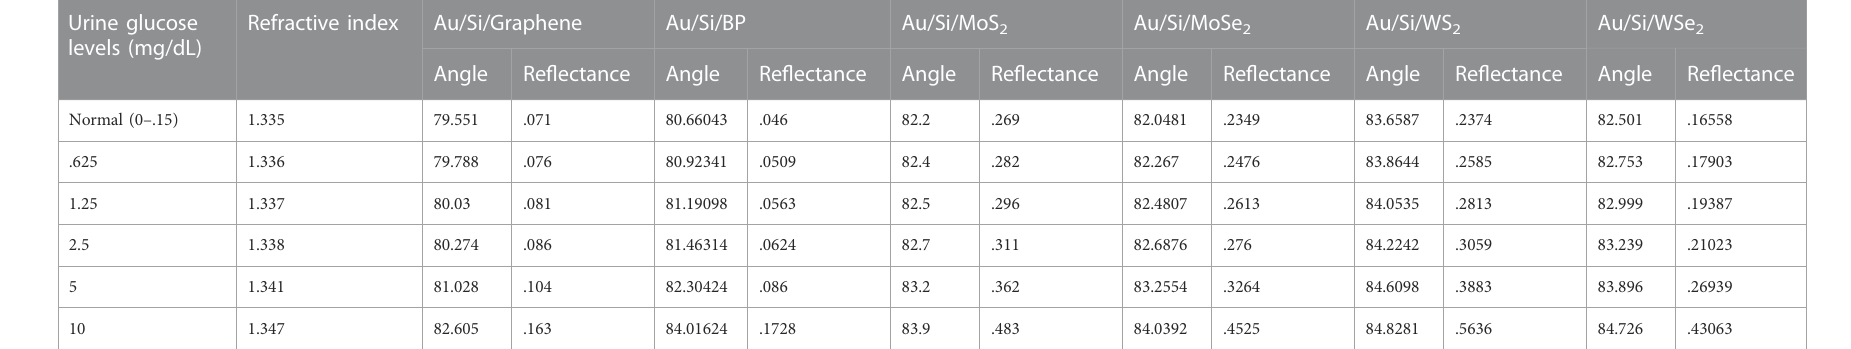
Angle Re fl ectance Angle Re fl ectance